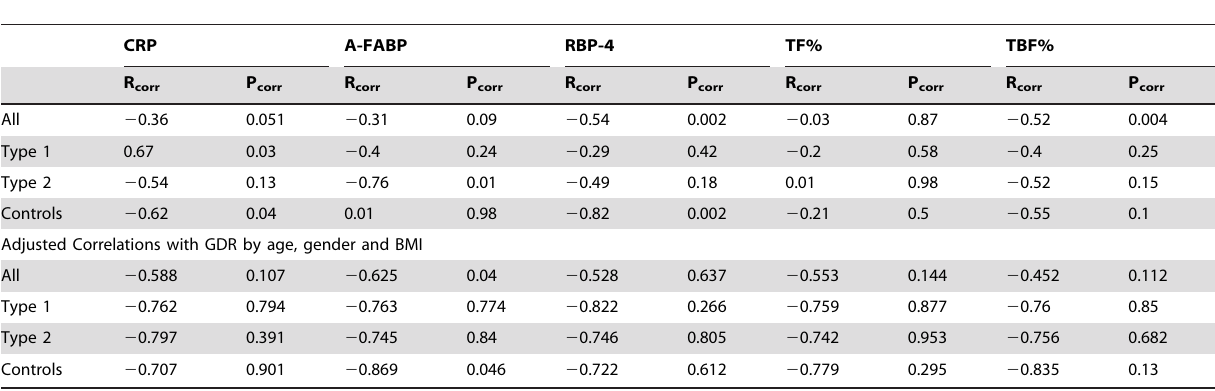
Table 2. Gross and Adjusted Correlations with GDR.